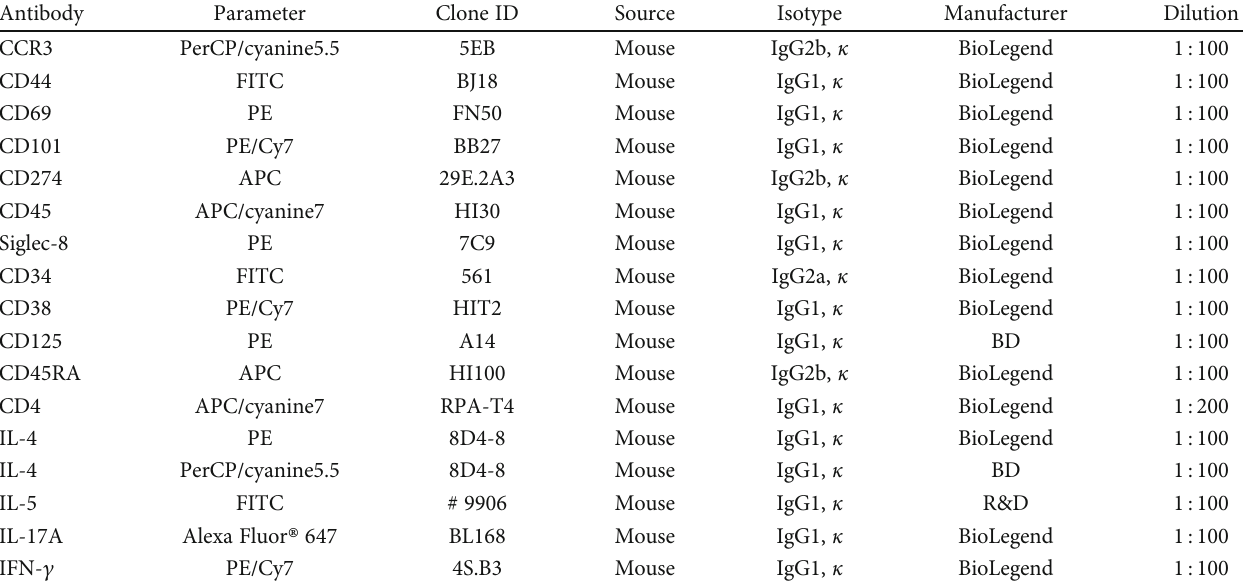
Table 1: Antibodies used for fl ow cytometry.